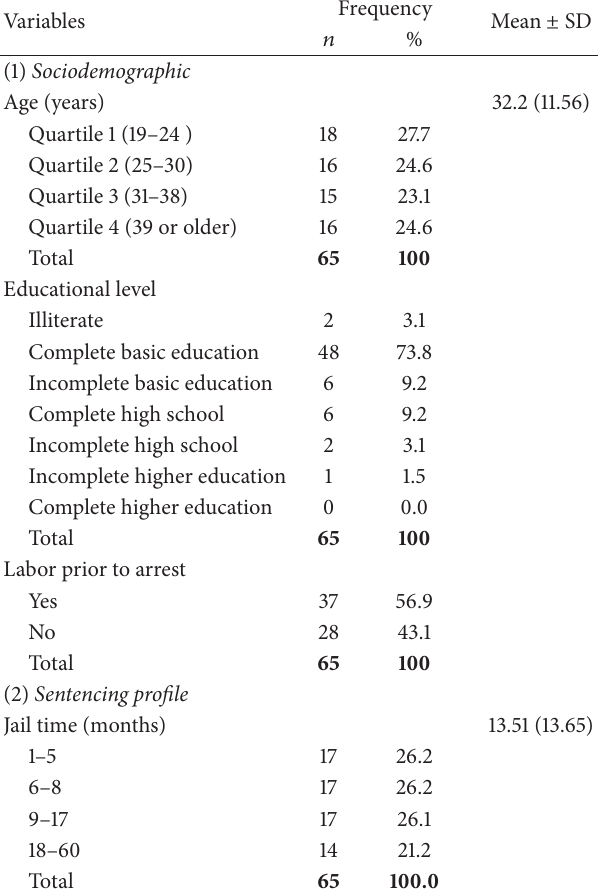
Table 1: Distribution of inmates according to sociodemographic and sentencing profile.